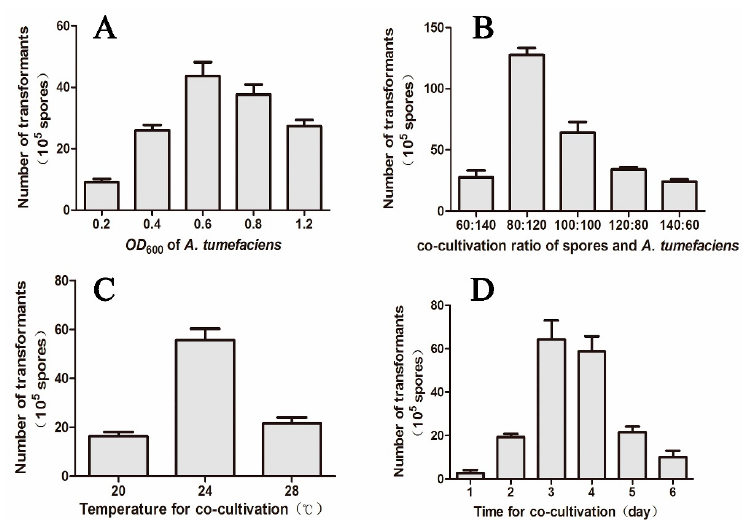
Figure 3. The parameters on the Agrobacterium tumefaciens -mediated transformation (ATMT) of M. eutypoides . ( A ) OD 600 of A. tumefaciens ; ( B ) co-cultivation ratio of spores and A. tumefaciens ; ( C ) temperature for co-cultivation; ( D ) time for co-cultivation. Bars denote standard error. Different letters in the same column in the same cultural condition indicate significant difference at p ≤ 0.05 level by the Tukey–Kramer multiple comparison test.